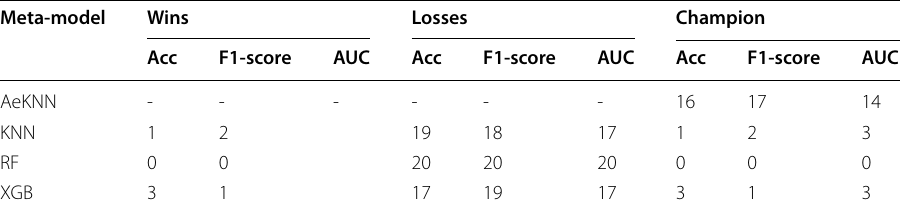
Table 7 Comparing each baseline meta-model against AeKNN on the 20-benchmark datasets. Listed are the number of datasets where each meta-model produced better predictions than AeKNN (Wins) , worse predictions (Losses) , or more accurate predictions than all of the other 3 meta- models (Champion)